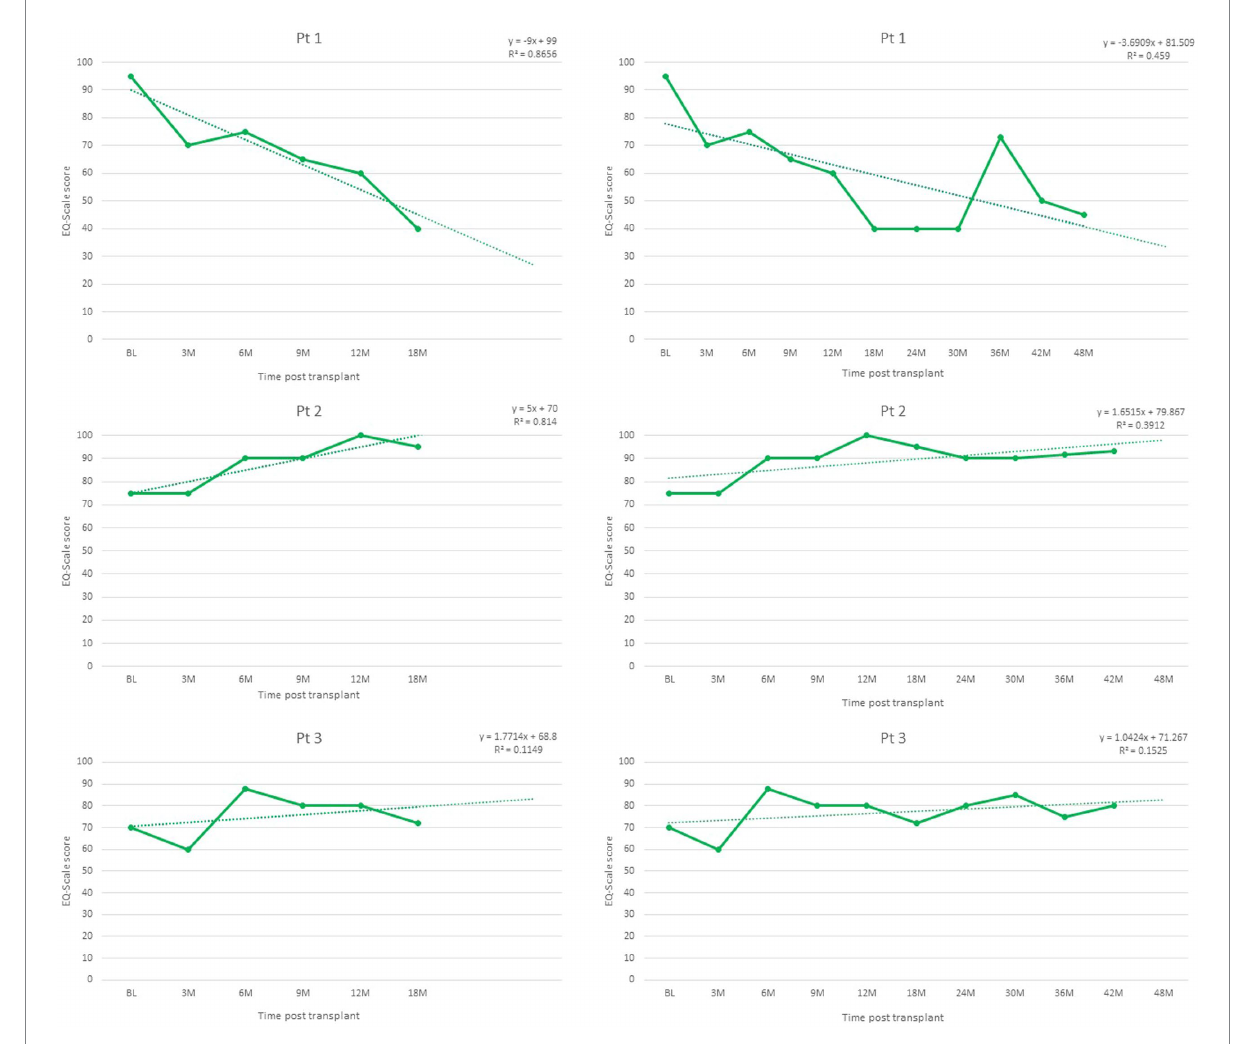
FIGURE 4 Quality of Life trajectories post-transplant, as measured by EQ-Scale scores, range